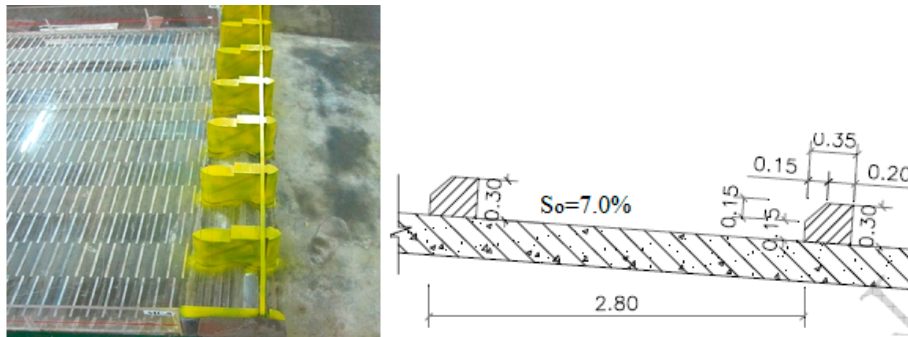
Figure 3. Physical model of the complete case and dimensions of the wall [16].